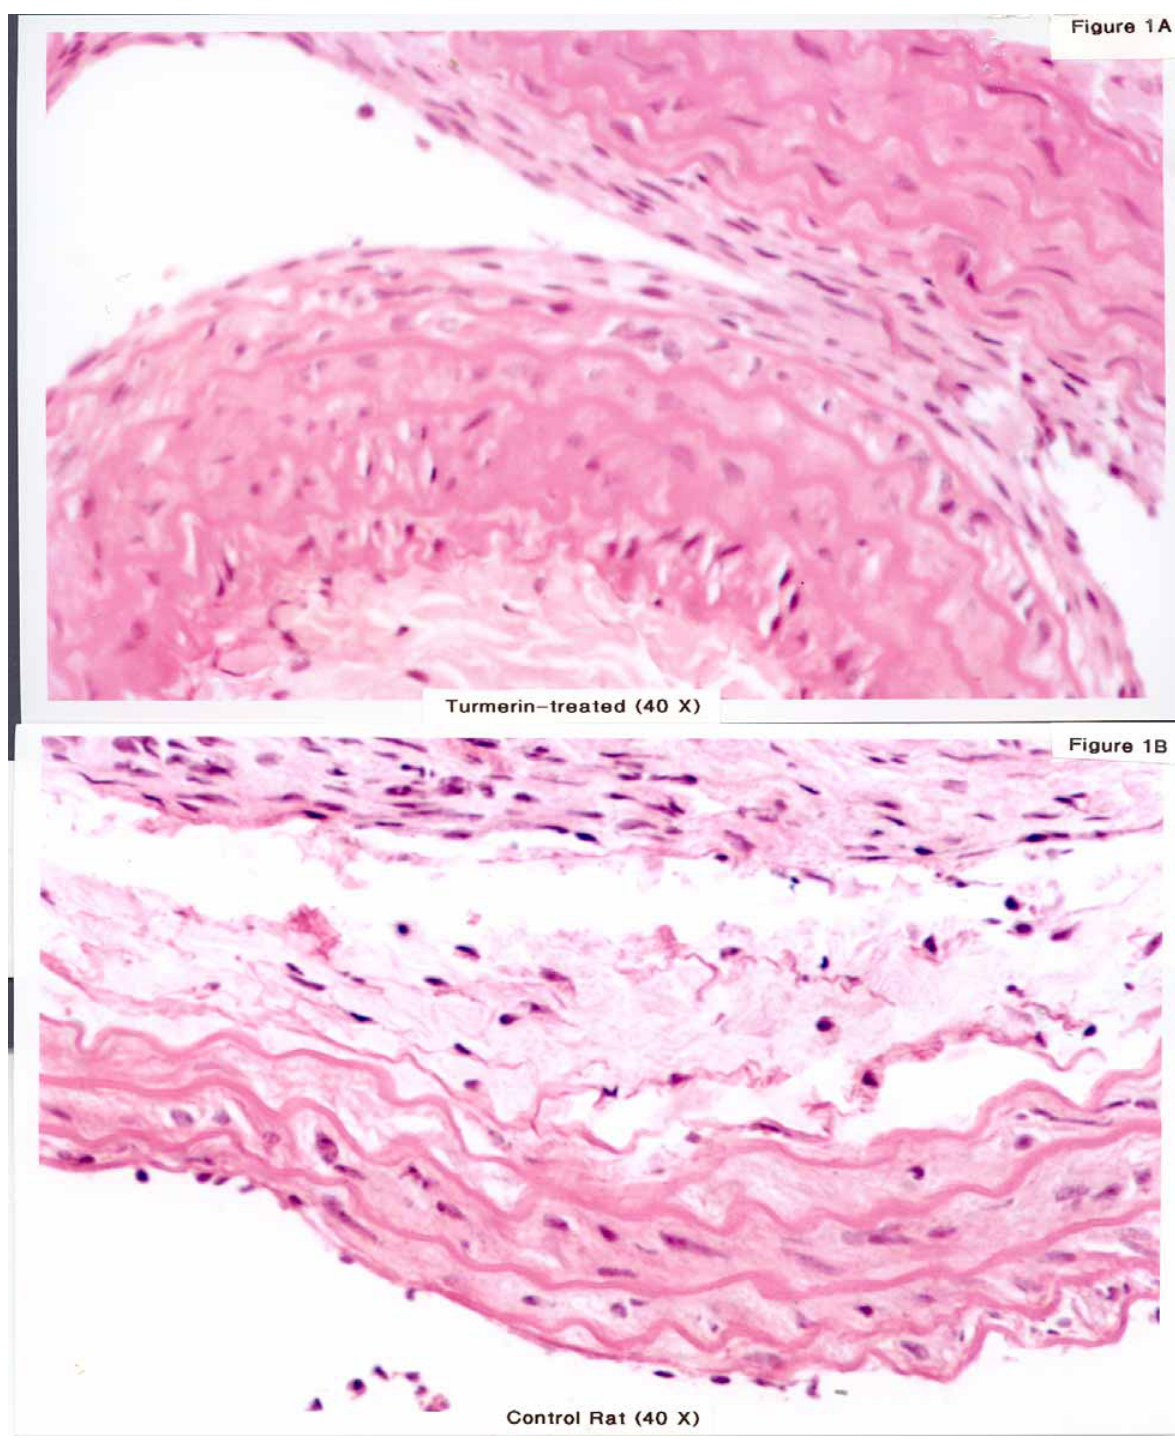
Figure 1. Cross section of common carotid artery 14 days after denudation by air-drying. A. Animals treated locally with turmerin for 5 mins and by daily gavaging with 1ml turmerin showed a reduced intima in 1/6 rats(x 40, H & E stain). B. Animals treated locally with saline for 5 mins and by daily gavaging with 1 ml saline showed an increased intima and hyper-proliferation and edema of smooth muscle cells. Only one out of six rats showed no proliferation in the intima while there was significant variation in